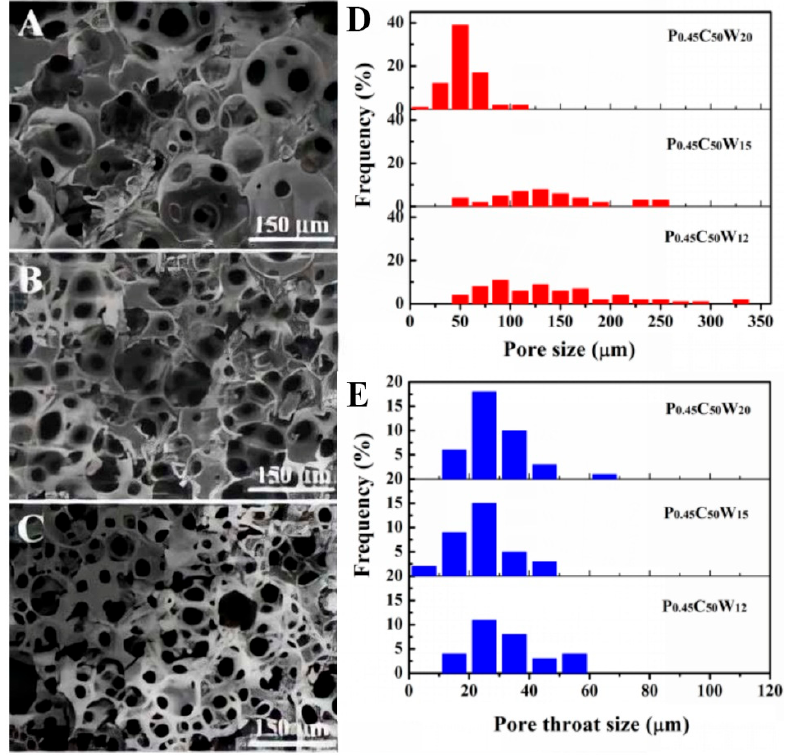
Figure 4. The SEM images of ( A ), ( B ), and ( C )of P 0.45 C 50 W z templated from C/W HIPEs containing 12, 15, and 20 mL aqueous solution, respectively; ( D ) and ( E ) are the distribution charts of pores and pore throats, respectively.